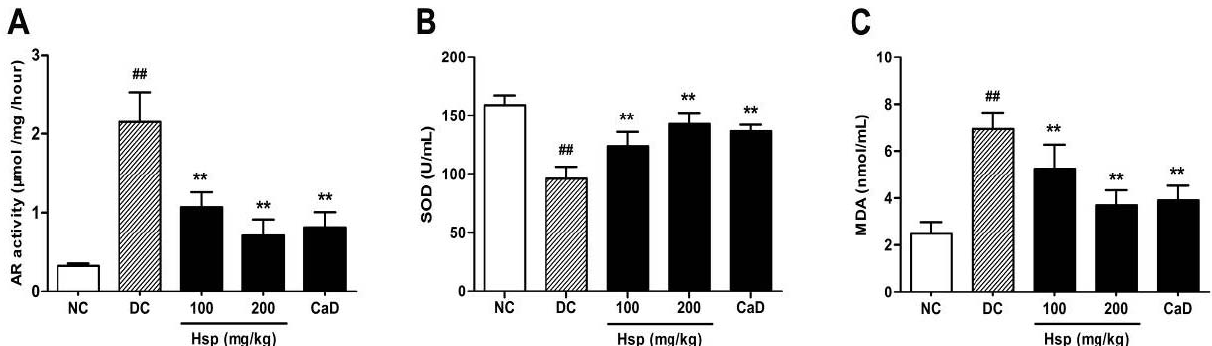
Figure 4. Effects of Hsp and CaD on ( A ) aldose reductase activity in rat eyes; ( B ) SOD activity and ( C ) MDA levels in serum of rats. ## p < 0.05 as compared with the NC group; * p < 0.05, ** p < 0.01 as compared with the DC group; NC, Normal Control; DC, Diabetic Control. The data represent means ±